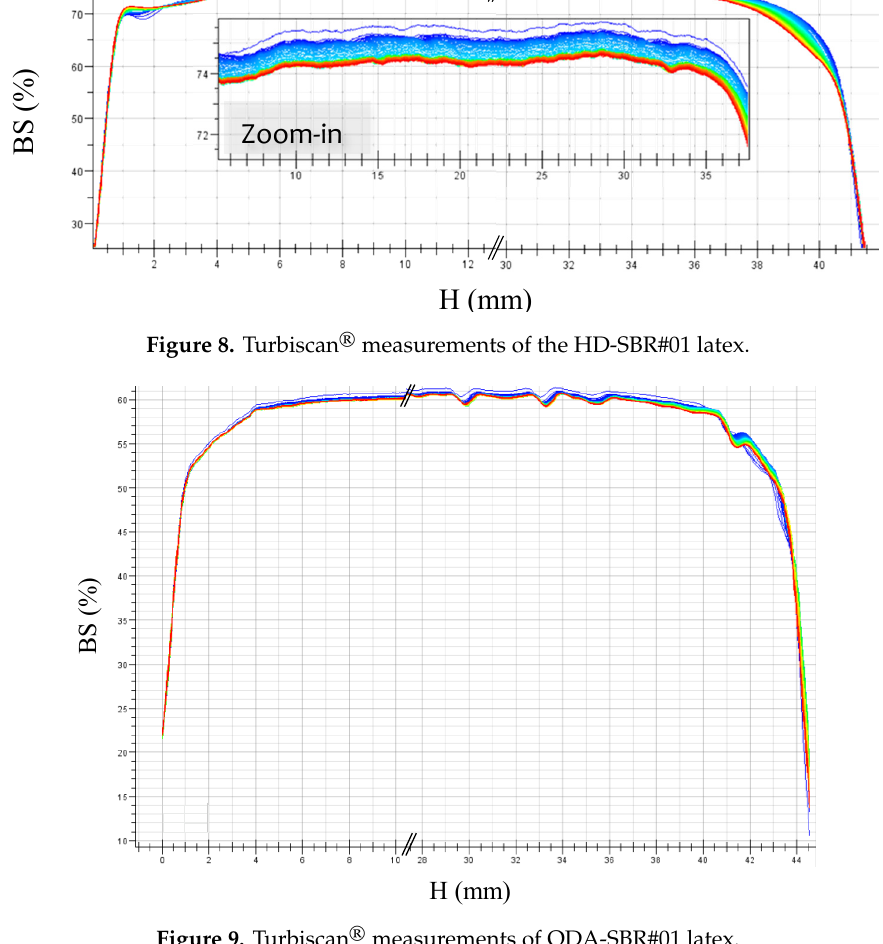
Figure 9. Turbiscan ® measurements of ODA-SBR#01 latex.